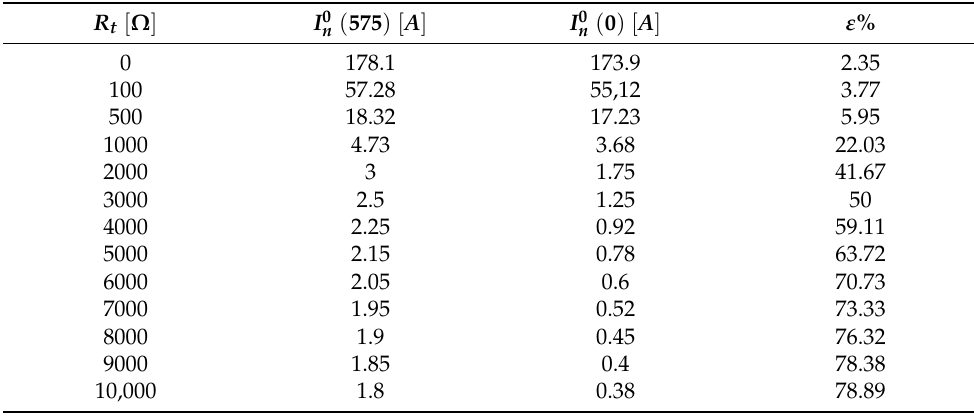
Table 4. The insulation of medium voltage network is imperfect ( tan δ = 0.105 )